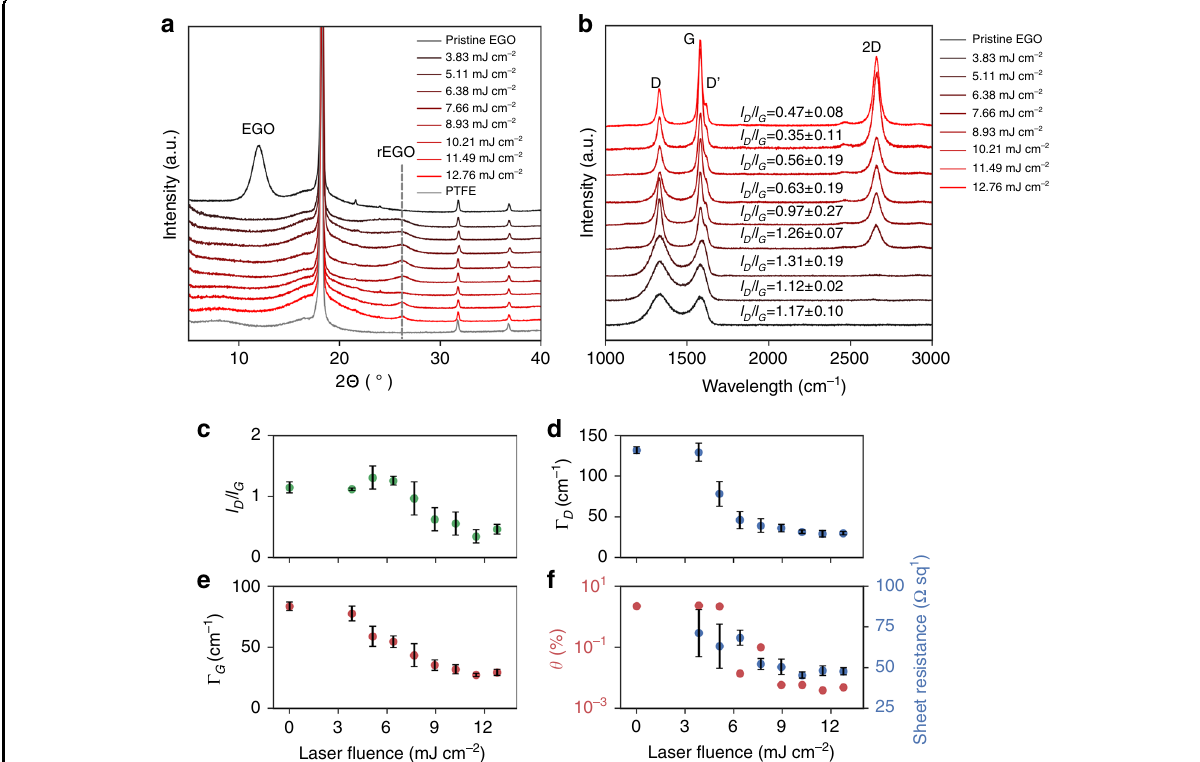
Fig. 4 Characterizations of the Pt-LrEGO prepared with different laser fl uences. a XRD patterns (the diffraction peaks centered at 2 θ = 18.1°, 31.7°, and 36.8° in the XRD pattern originated from the PTFE membrane fi lter) and b representative Raman spectra of the pristine EGO and LrEGO after 1064 nm laser irradiation at various laser fl uences. The evolution of c I D /I G ratio, d , e FWHM values of D and G bands, and f defect density ( θ ) and sheet resistance of EGO and LrEGO